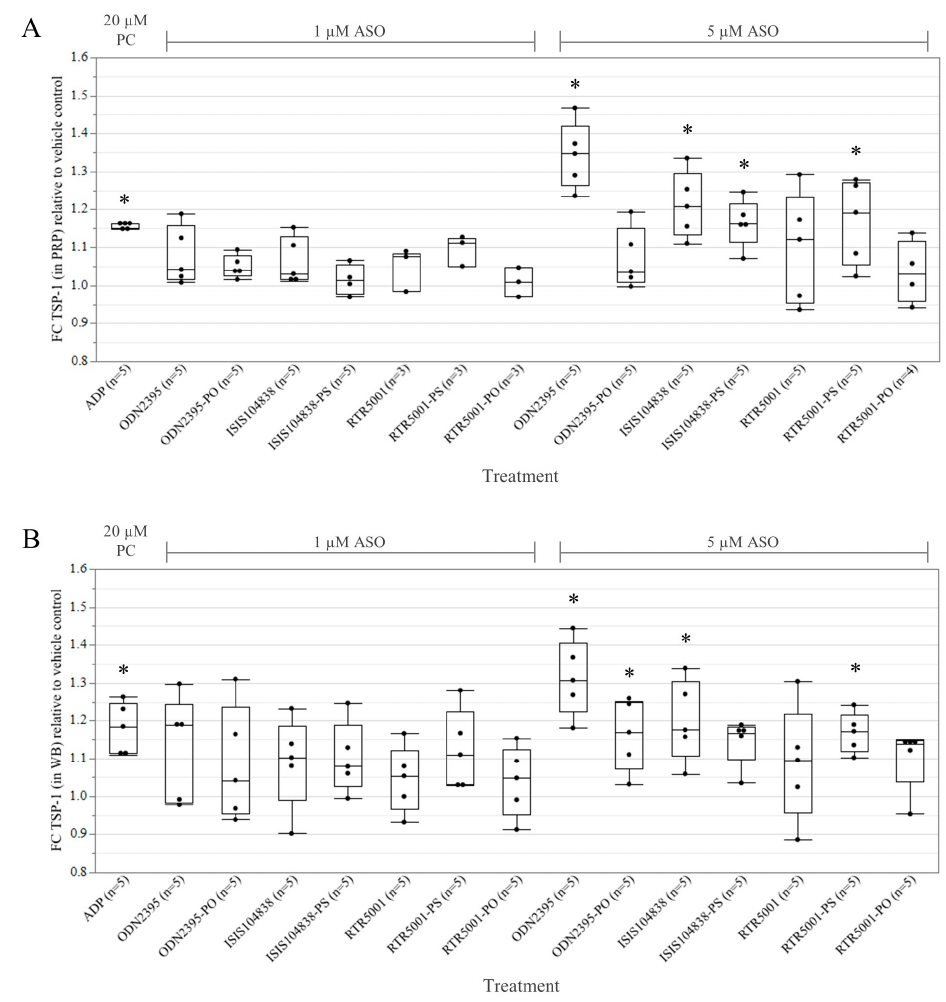
Figure 1. Effects of 1 and 5 µ M antisense oligonucleotides (ASOs) on the platelet activation marker, thrombospondin 1 (TSP-1) in Göttingen minipig ( A ) platelet-rich plasma and ( B ) whole blood. An amount of 20 µ M ADP as positive control (PC) in parallel with the panel of ASOs was incubated for 30 min with either platelet-rich plasma or whole blood from adult minipigs. Change in TSP-1 level in each treatment group is expressed as fold change (FC) with respect to the vehicle control (DPBS). * p < 0.05 compared with the vehicle by linear mixed model, with Dunnett post hoc test.